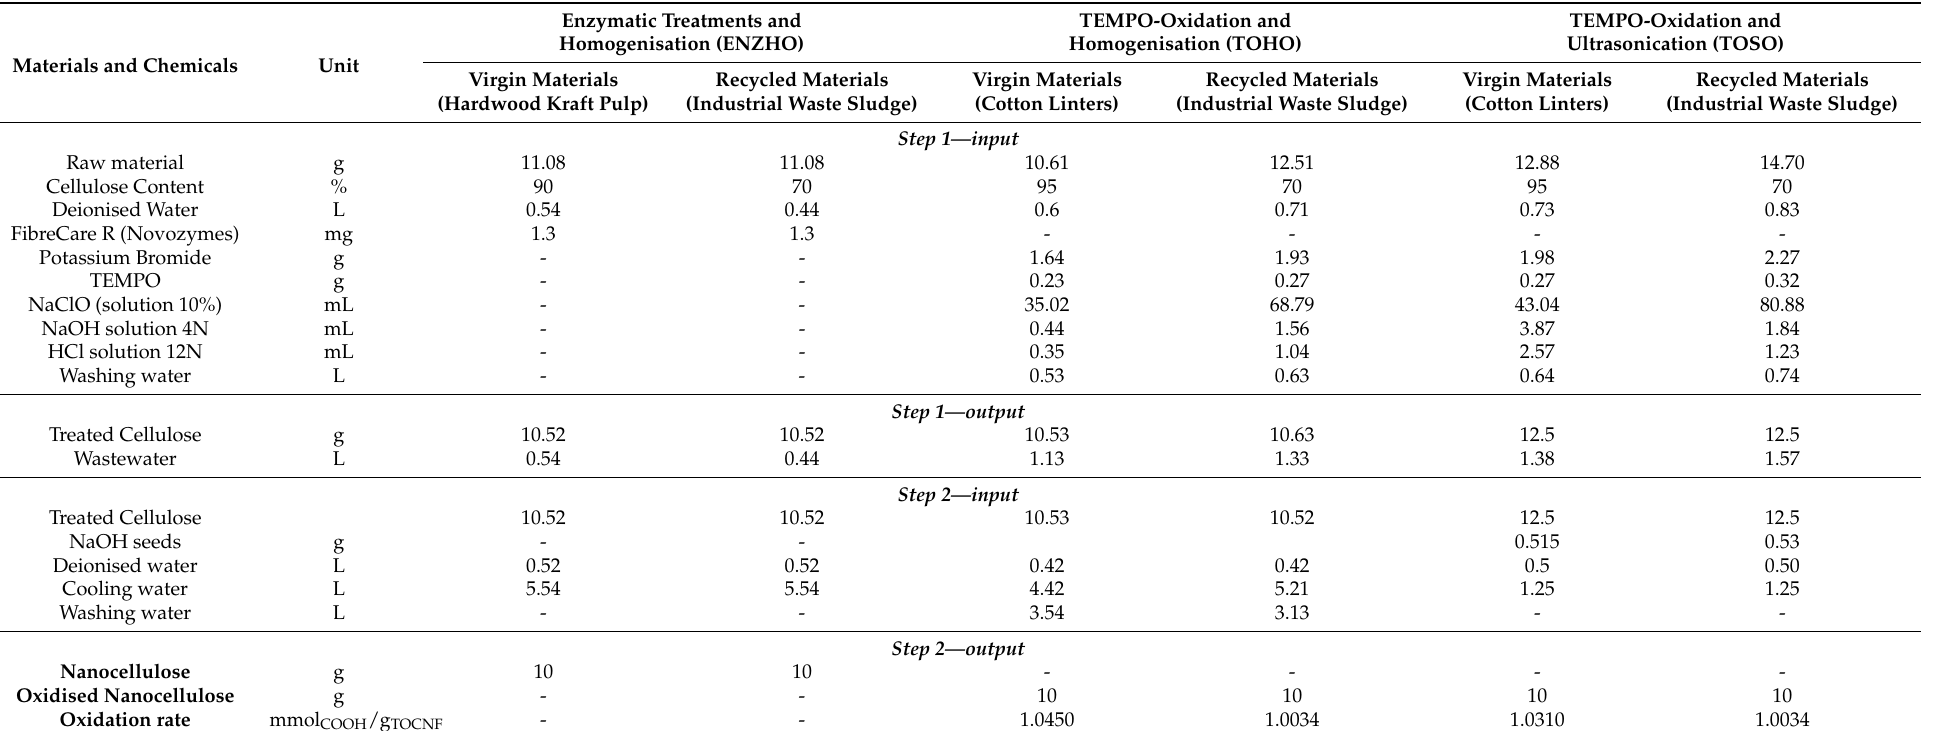
Table 2. Inventory of the chemicals, water, and raw materials for the six CNFs produced at the lab scale; amounts are given per